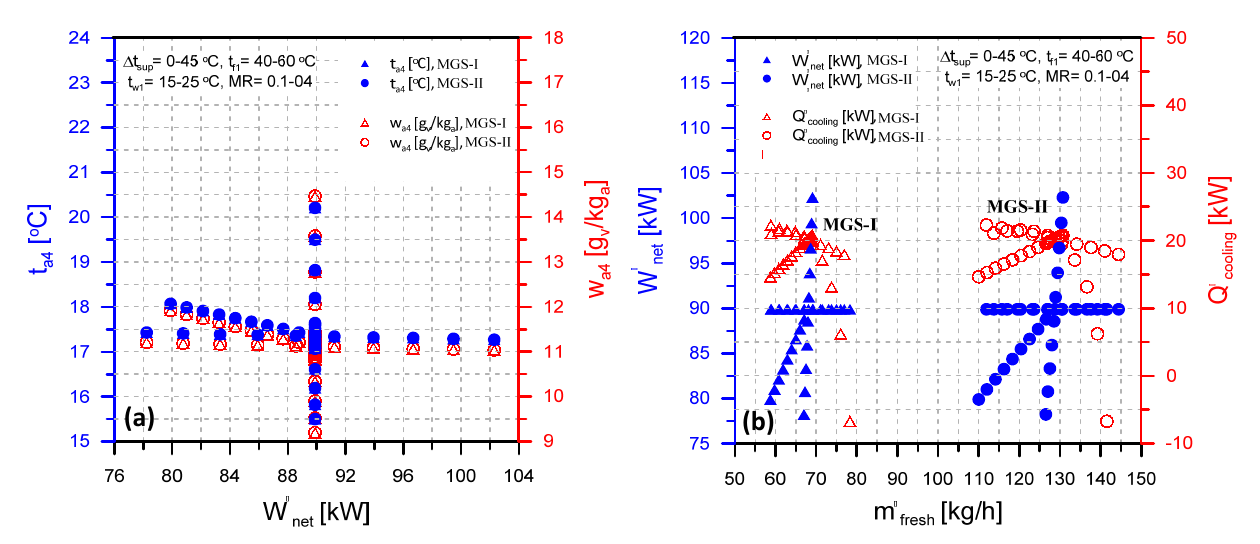
Figure 11. System assessment and evaluation: ( a ) Space-supplied air conditions versus produced fresh water rate, ( b ) power output and space cooling capacity versus produced fresh water rate.